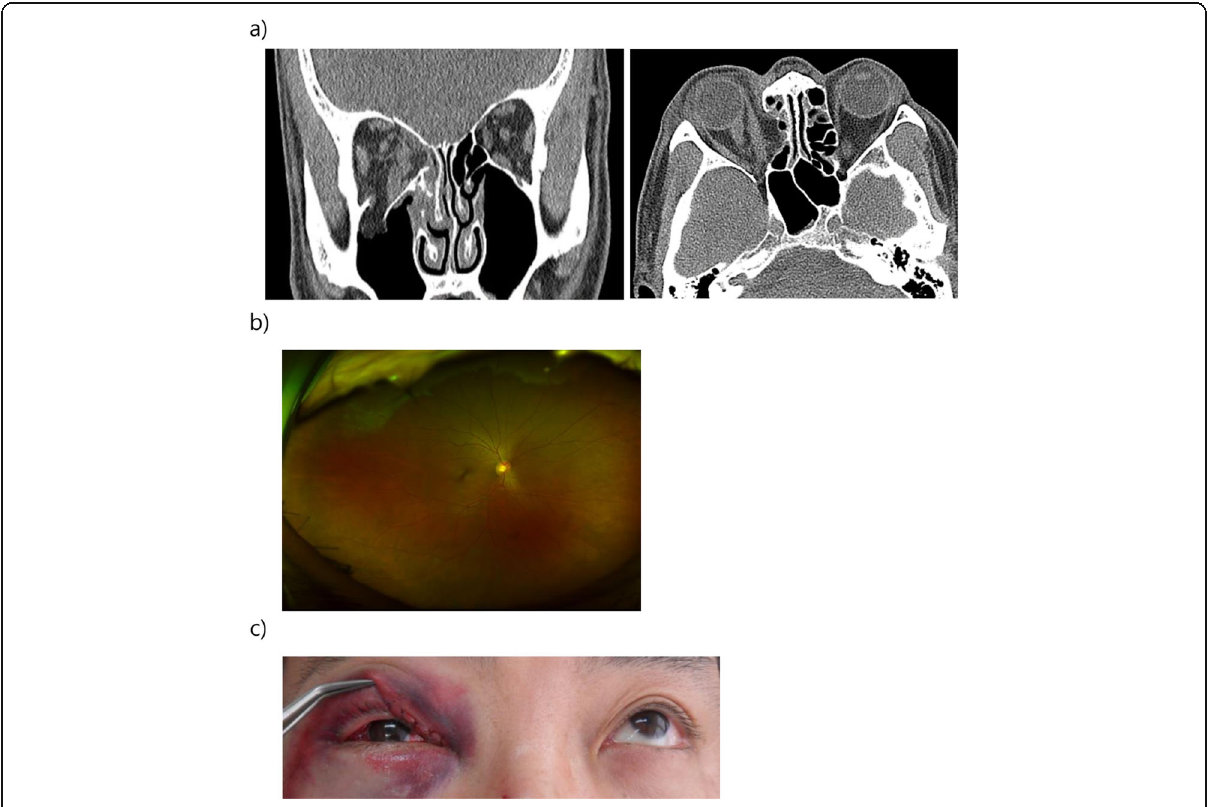
Fig. 1 Preoperative CT images, fundus photograph, and eyelid photo. a Coronal and axial section showing fracture of the right superior/inferior/ medial orbital wall and entrapment of the right inferior rectus muscle with orbital fat herniation to the right maxillary antrum. b Fundus photograph showing non-specific sign. c The limitation of the upward gaze is